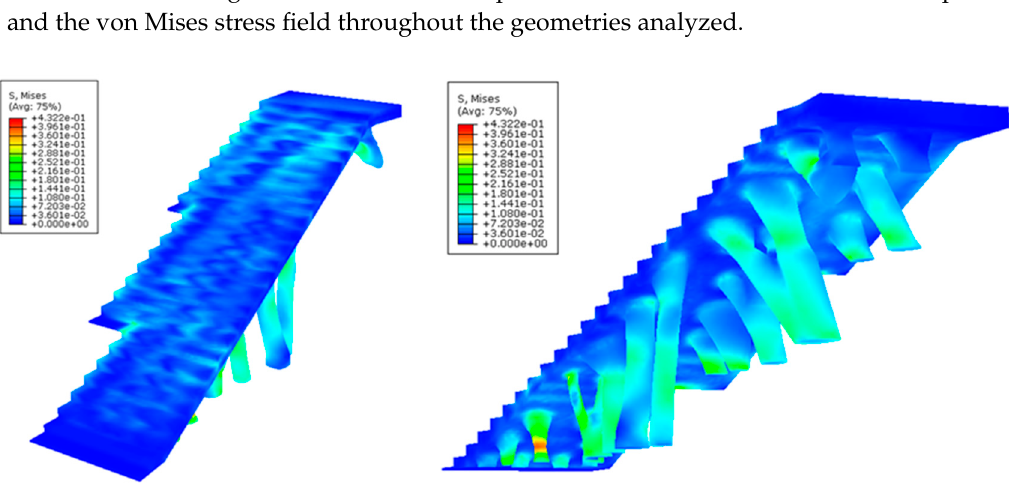
Figure 26. Field of the von Mises stress (MPa) obtained in the mechanical simulations: the BIM building element E 2 indicated in two perspectives in the left and right pictures. Figure 27. Field of displacements (mm) obtained in the mechanical simulations: the BIM building element E 1 indicated in two perspectives in the left and right pictures.